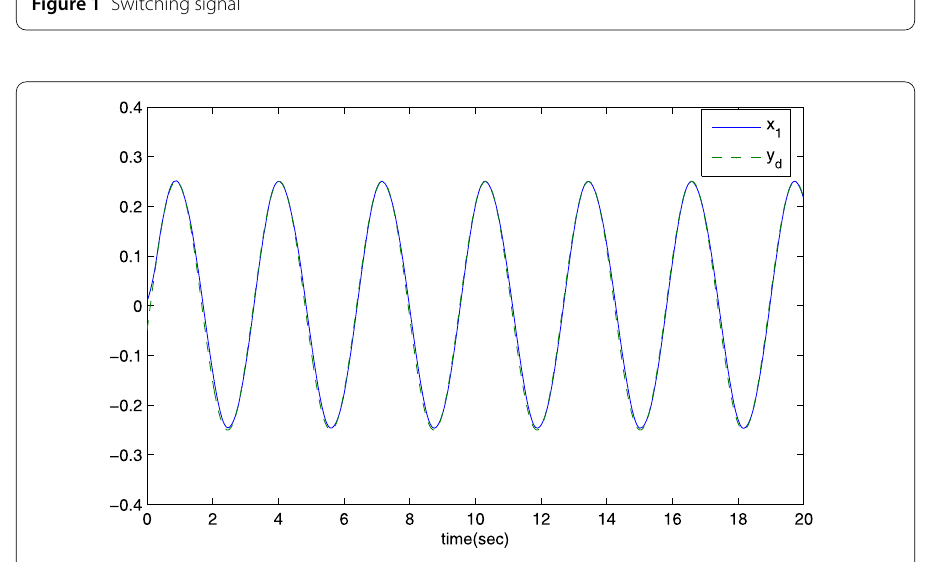
Figure 2 Tracking performance of